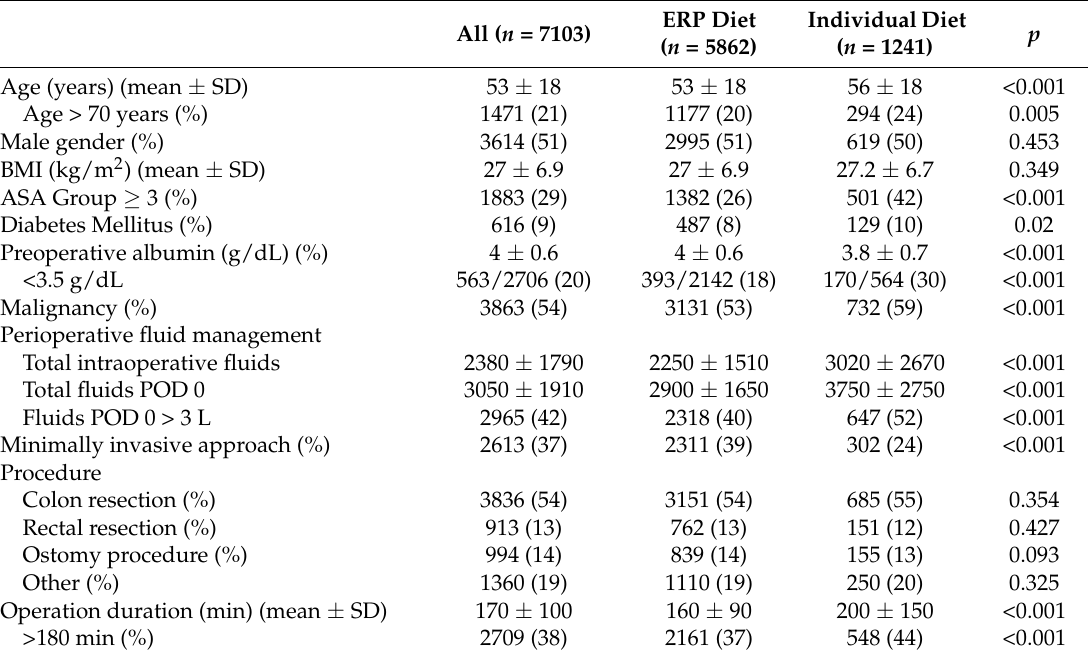
Table 1. Demographic and surgical